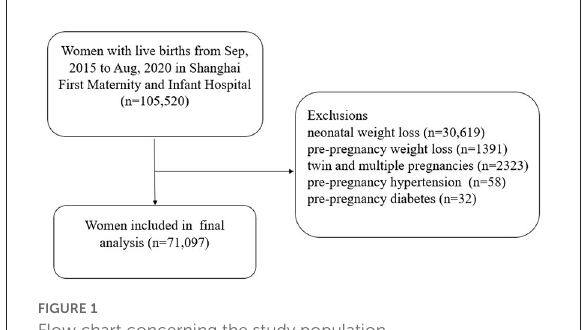
FIGURE1 Flow chart concerning the study population.